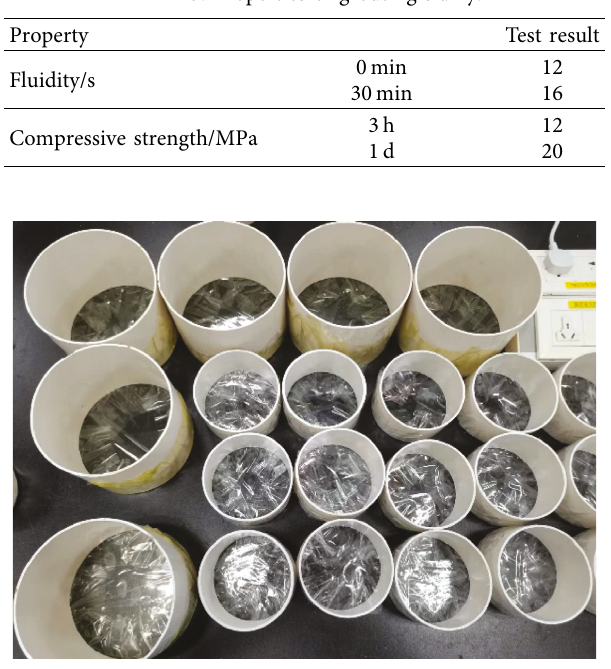
Figure 3: PAV tubes for fabrication of the cementitious sample.